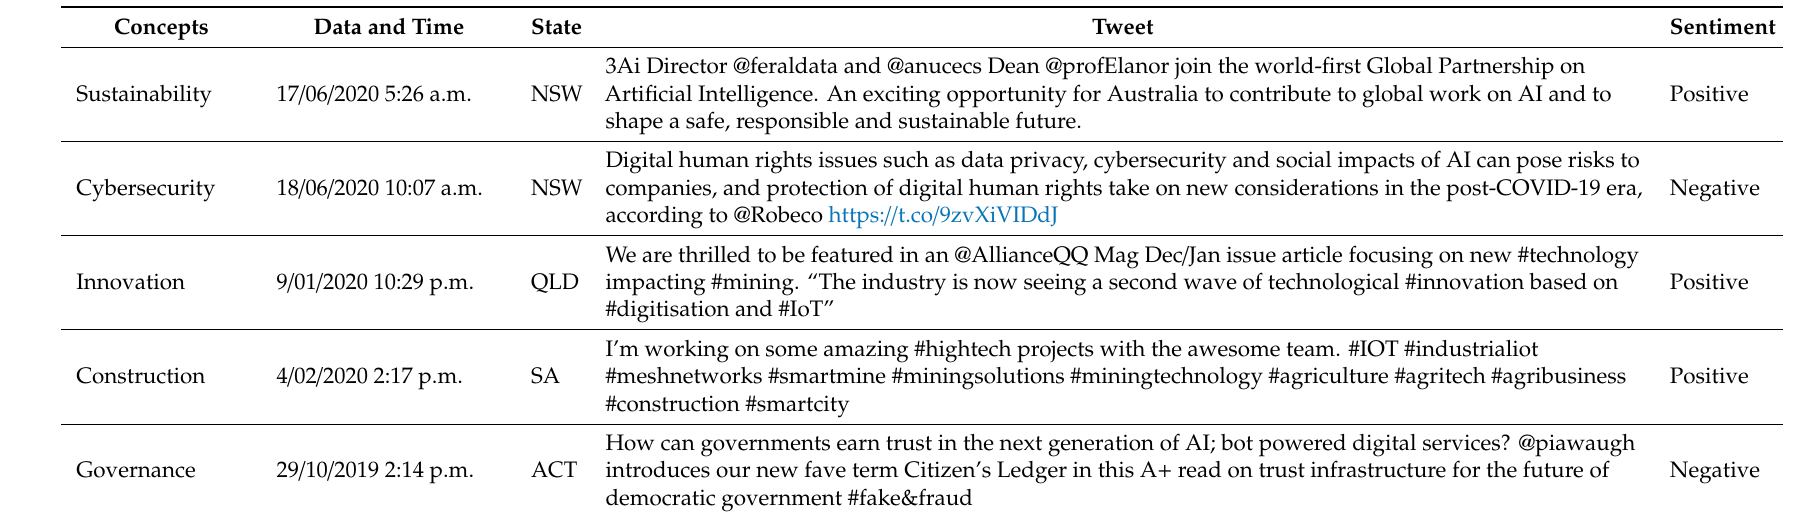
Table 6. Example tweets for urban planning and development